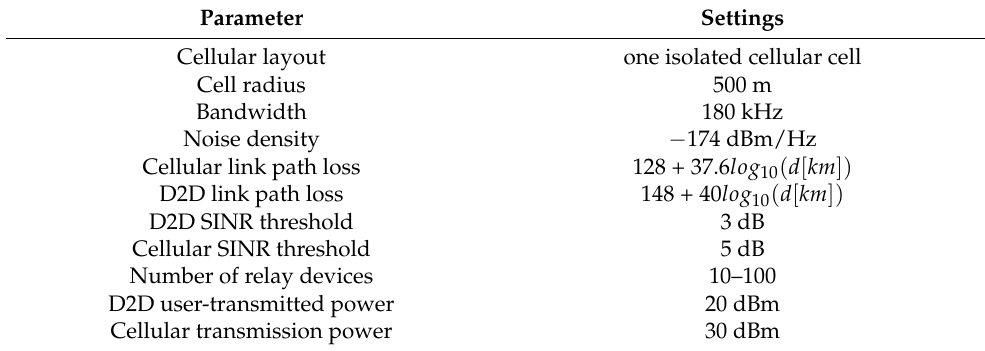
Table 1. Simulation Parameters.